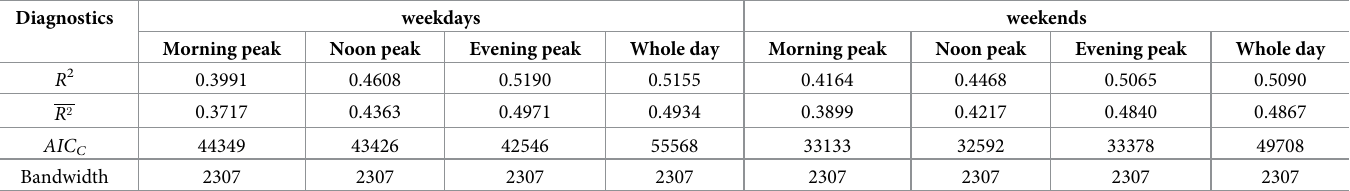
Table 8. Results of the GWR model of urban POIs (12) on weekdays and